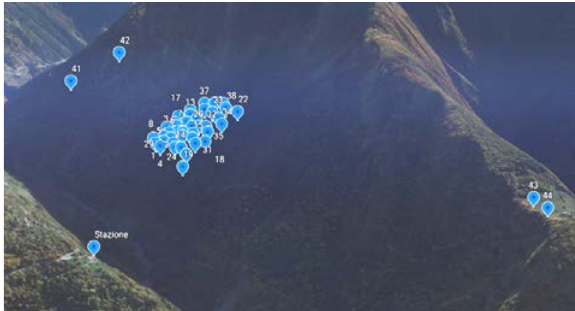
Figure 3. Locations of the robotic total station (RTS), control points (CPs) on the landslide body and reference points for environmental calibration on stable areas (No. 41-44).